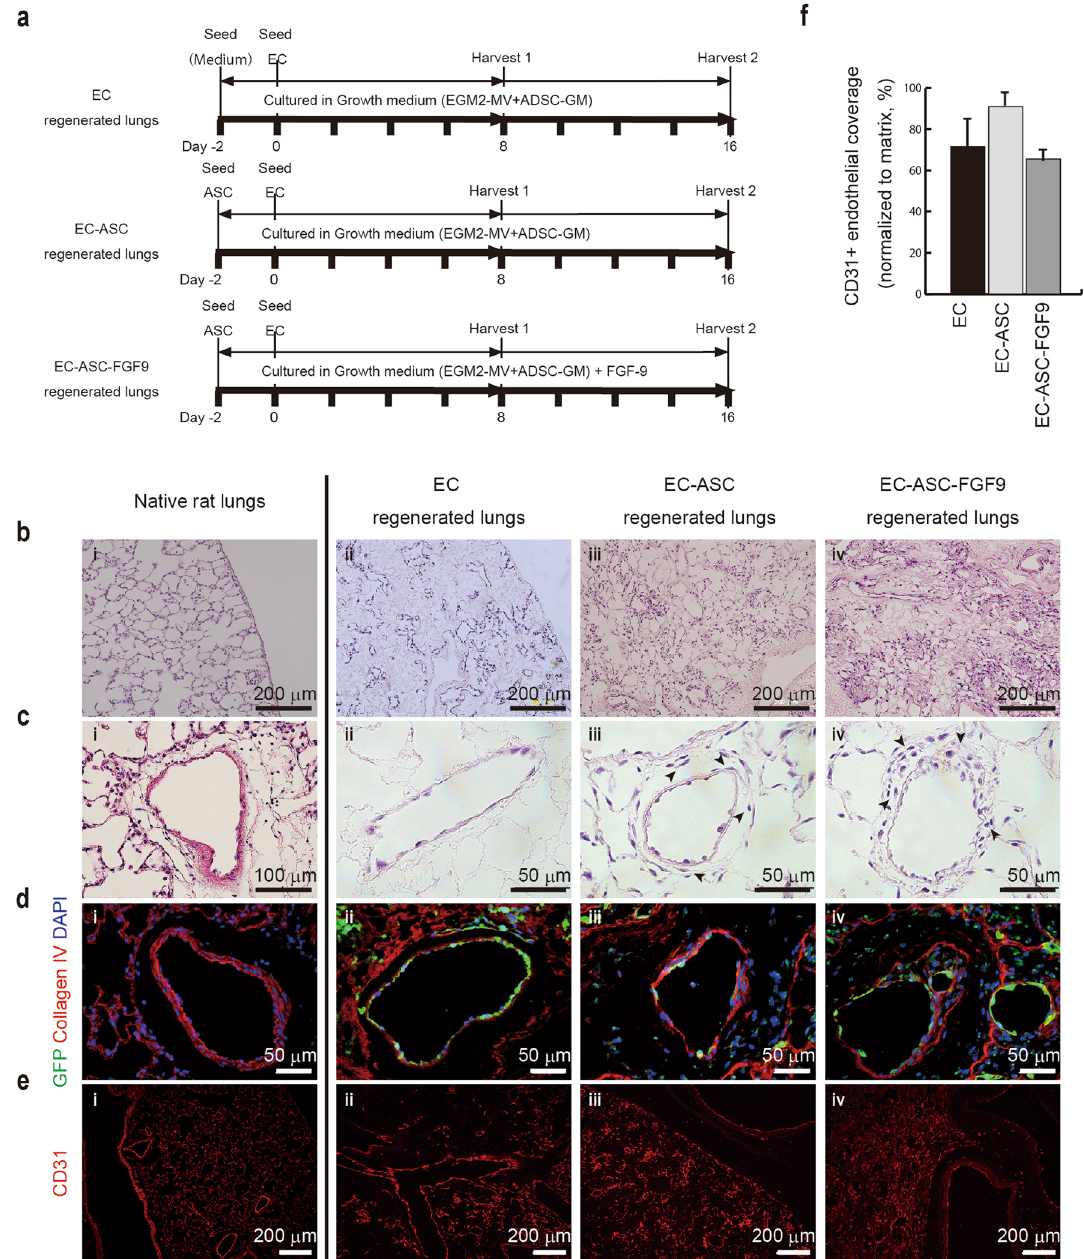
Figure 4. ASCs enhanced endothelium coverage, localized beside the endothelium monolayer, and migrated into the vascular adventitia and stroma in acellular scaffolds at day 8 of the culture. ( a ) Schematic recellularization protocol. EC-regenerated lung repopulated with eGFP-ECs alone; EC–ASC-regenerated lung repopulated with a combination of eGFP-ECs and QDs655-ASCs; EC–ASC–fibroblast growth factor 9 (FGF9)- regenerated lung repopulated with a combination of eGFP-ECs and QDs655-ASCs and cultured in EGM2-MV/ ADSC-GM with FGF9. ( b,c ) H&E stained low- ( b , x10) and high- ( e , x40) magnification views of thin sections from native (i), EC- (ii), EC–ASC- (iii), and EC–ASC–FGF9- (iv) regenerated lungs. ECs distributed throughout the lung parenchyma ( c , ii) and formed a complete endothelium monolayer in the EC-, EC–ASC-, and EC– ASC–FGF9-regenerated lungs. Other cells (black arrowheads, ECs or ASCs) localized to the tunica adventitia of the pulmonary vasculature in the EC–ASC- and EC–ASC–FGF9-regenerated lungs. ( d ) Immunofluorescence micrographs of thin sections from native (i) and regenerated (ii–iv) lungs showing the expression of collagen-IV and engraftment of GFP-ECs. ASCs (stained with DAPI alone) engrafted both in the basement membrane and in the tunica adventitia in the EC–ASC- and EC–ASC–FGF9-regenerated lungs. ( e ) Immunofluorescence micrographs of thin sections from native (i) and regenerated (ii–iv) lungs showing expression of CD31. ( f ) Quantification of endothelial coverage in EC-, EC–ASC-, and EC–ASC–FGF9-regenerated lungs after 8 days in culture. All values are means ± standard deviation 54 of three independent experiments. P = 0.0554 (ANOVA); P = 0.1767 (Kruskal–Wallis